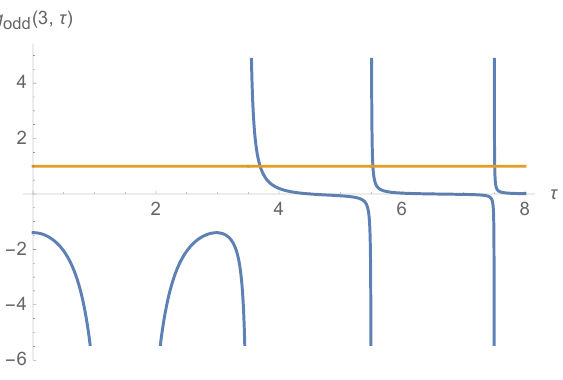
Figure 5. A plot g odd (3 ; (cid:28) ) and 1 for d =